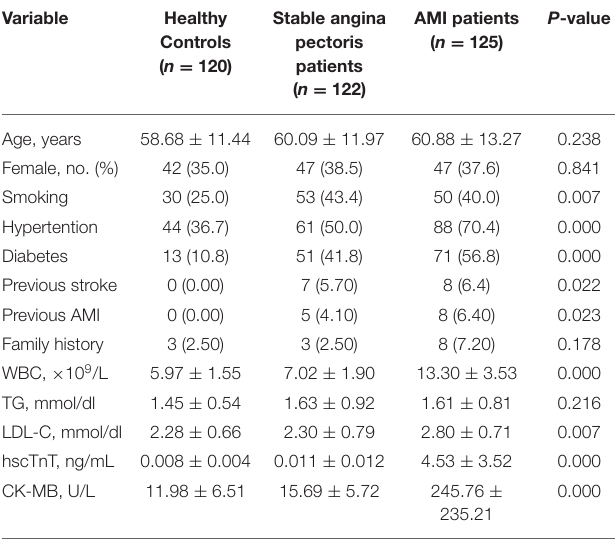
TABLE 1 | Baseline demographic and clinical parameters among the healthy control, stable angina pectoris and AMI subjects. Variable